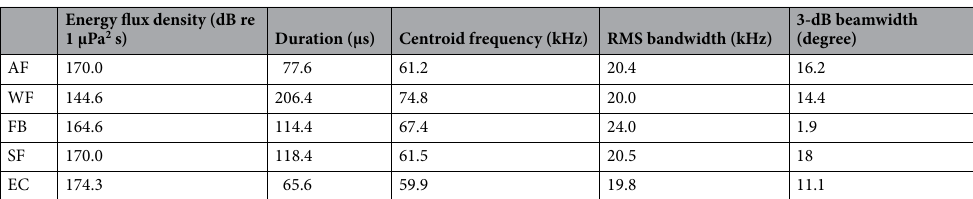
Table 1. Energy flux density, duration, centroid frequency, RMS bandwidth, and 3-dB beamwidth of the simulated receiving echoes in each case, as well as the five parameters of the emitted click (EC) at 1 m away from the phonic lips in the